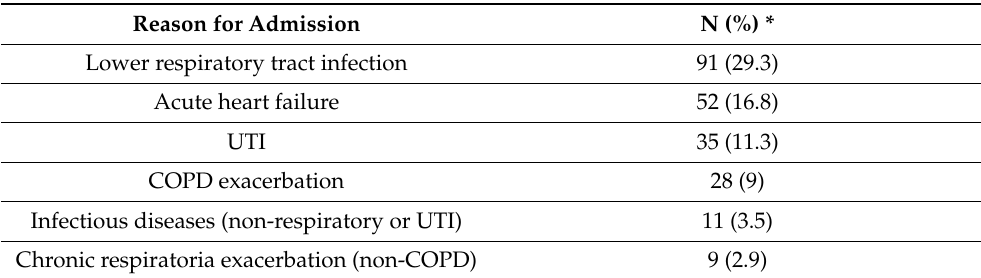
Table 2. Main reason for admission before multi-organ point-of-care ultrasound (N = 310) Table 1. Demographics, clinical characteristics, and ultrasound severity classification of patients in- cluded.